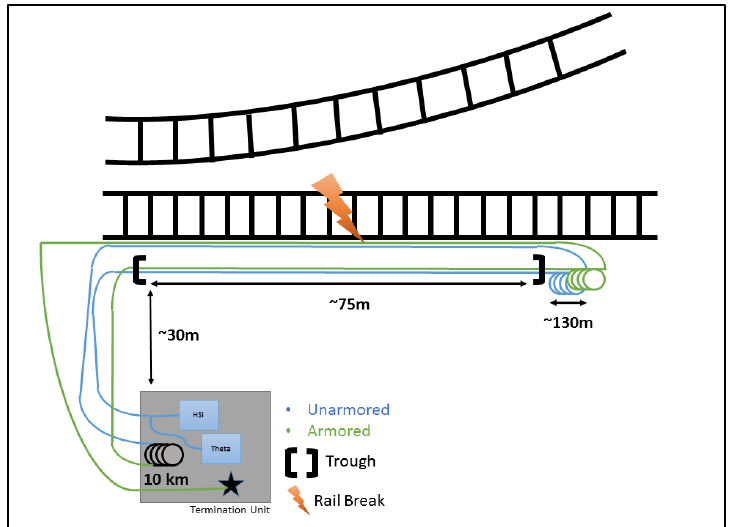
Figure 3. Schematic illustration of experiment test track section .